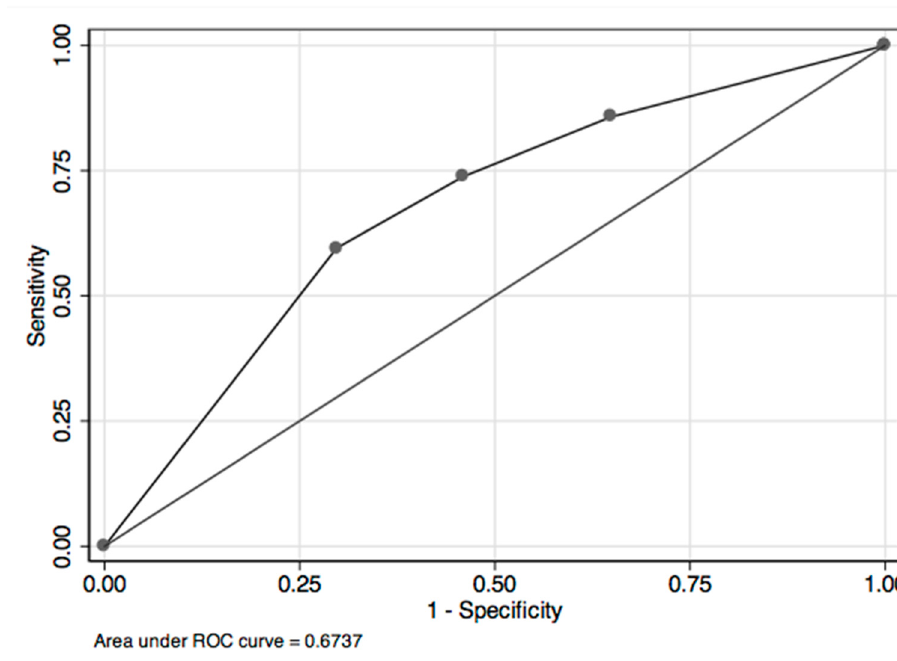
Figure 3. Roc Curve (AUC 0.67; p = 0.04) for galectin-3 value combined with BNP value.